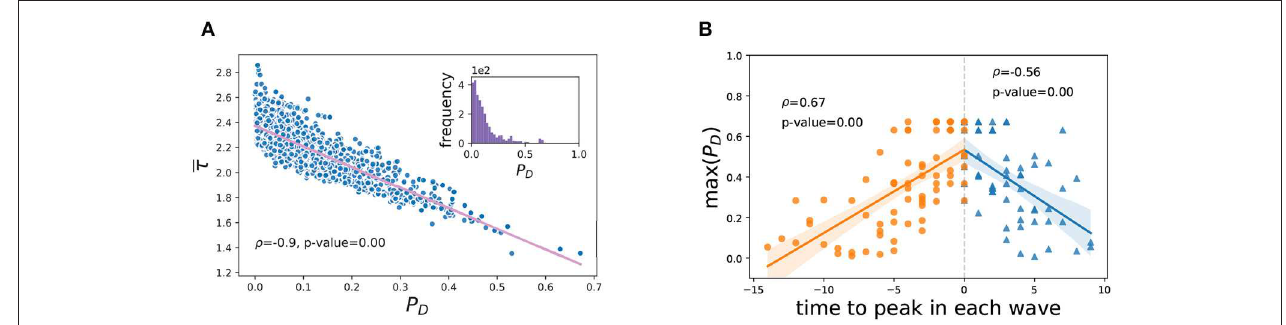
FIGURE 3 | (A) The relationship between τ and P D . τ is the average cascading steps. P D is the probability of being driving nodes. The Pearson correlation coefficient and p -value annotated in the plots are for the main axes. The inset in (A) describes the distribution of P D . (B) The relationship between the time to the peak moments for stocks reaching price limits and the maximum P D of failed stocks in every minute. We consider four trading days when market crashes, including June 26, June 29, July 2 and July 3 in 2015, as they considerably speak for the 2015 Chinese market crash and these four days are around the mutual fund ownership data’s disclosure date [25]. We first divide each trading day into a couple of non-overlapping time intervals where in each time interval there are stocks reaching down price limits continuously in minute-granularity (see Figure S1 ). These time intervals are called “waves,” as they possibly incorporate cascading failure of stocks, respectively. We also detect the peak minute(s) in every wave where the number of failed stocks hits the local maximum, indicating a wide range of stocks’ failures is happening. The gray dotted line indicates where the peak moments are and the results before or after the peaks are in different colors. The Pearson correlation coefficients and p -values annotated are for the points separated by the gray dotted line.